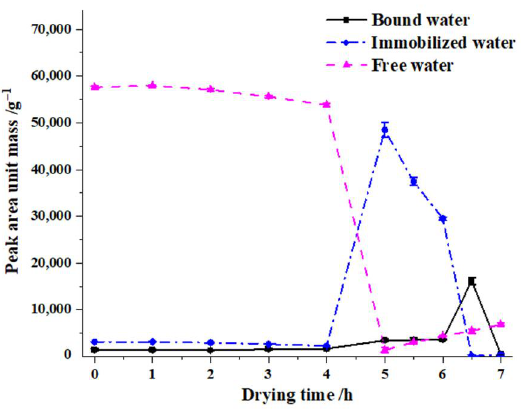
Figure 6. Moisture status of soybean dregs at different drying stages.